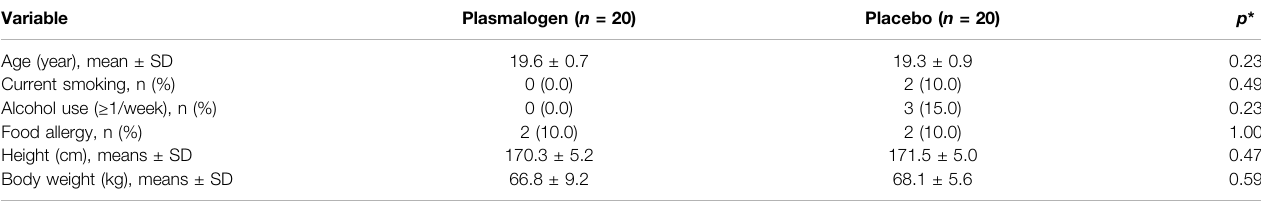
TABLE 2 | Background characteristics of the study participants.